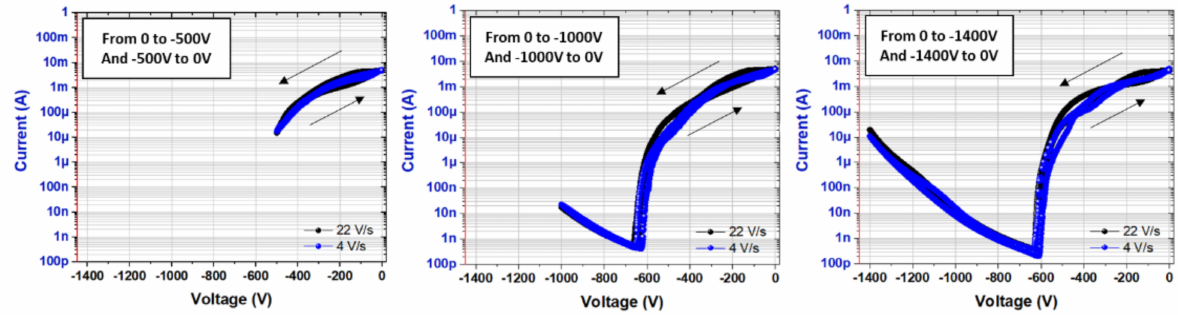
Figure 3. Substrate bias ramp measurements performed on the p-GaN/AlGaN/GaN HEMT on Si at room